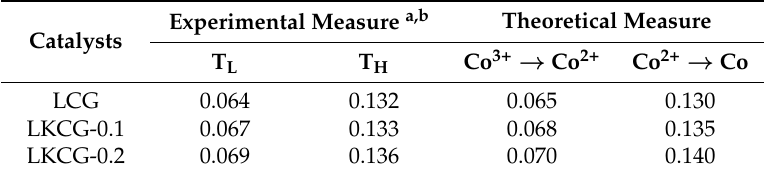
Table 1. Theoretical and experimental H 2 consumption value of the LKCG-x (x = 0.1 and 0.2) and LCG catalysts.